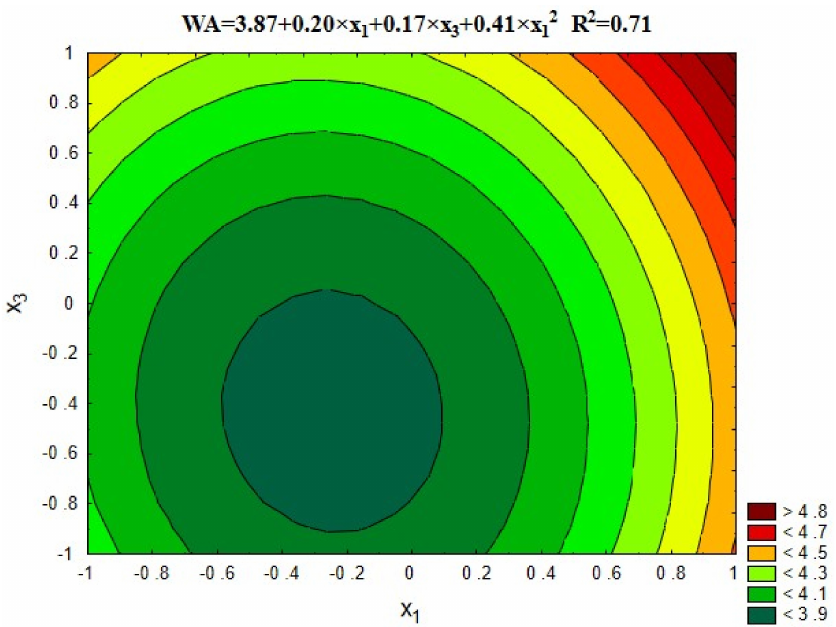
Figure 13. The water absorption of concrete depending on x 1 and x 3 (x 2 =